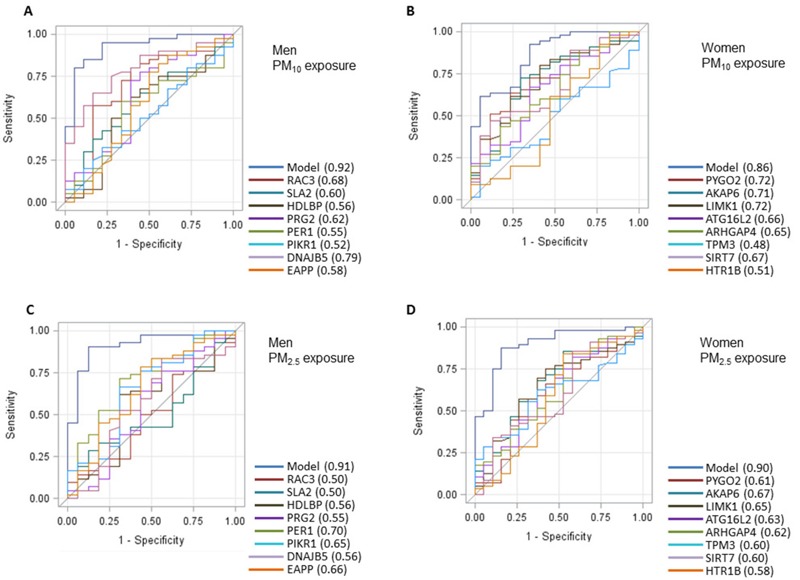
Receiver operating characteristics (ROC) curve for leukocyte gene expression of gene sets distinguishing between high and low long-term PM10 or PM2.5 exposure, respectively, based on the eight genes selected for validation for each sex. (A) performance of gene set consisting of DNAJB5, RAC3, SLA2, HDLBP, PRG2, PER1, PIK3R1, and EAPP to dinstinguish between high and low PM10 exposure in men (above 75th percentile corresponding to 24.5 μg/m3) and low (< 24.5 μg/m3) and (B) performance of gene set consisting of ARHGAP4, AKAP6, PYGO2, HTR1B, ATG16L2, SIRT7, TPM3 and LIMK1 in women to distinguish between high (above 75th percentile corresponding to: 25.7 μg/m3) and low (< 25.7 μg/m3) long-term residential PM10 exposure. (C) Performance of same male-specific gene set in men and (D) female-specific gene set in women to distinguish between high (above 75th percentile corresponding to: 16.0 μg/m3) and low (< 16.0 μg/m3) long-term residential PM2.5 exposure.